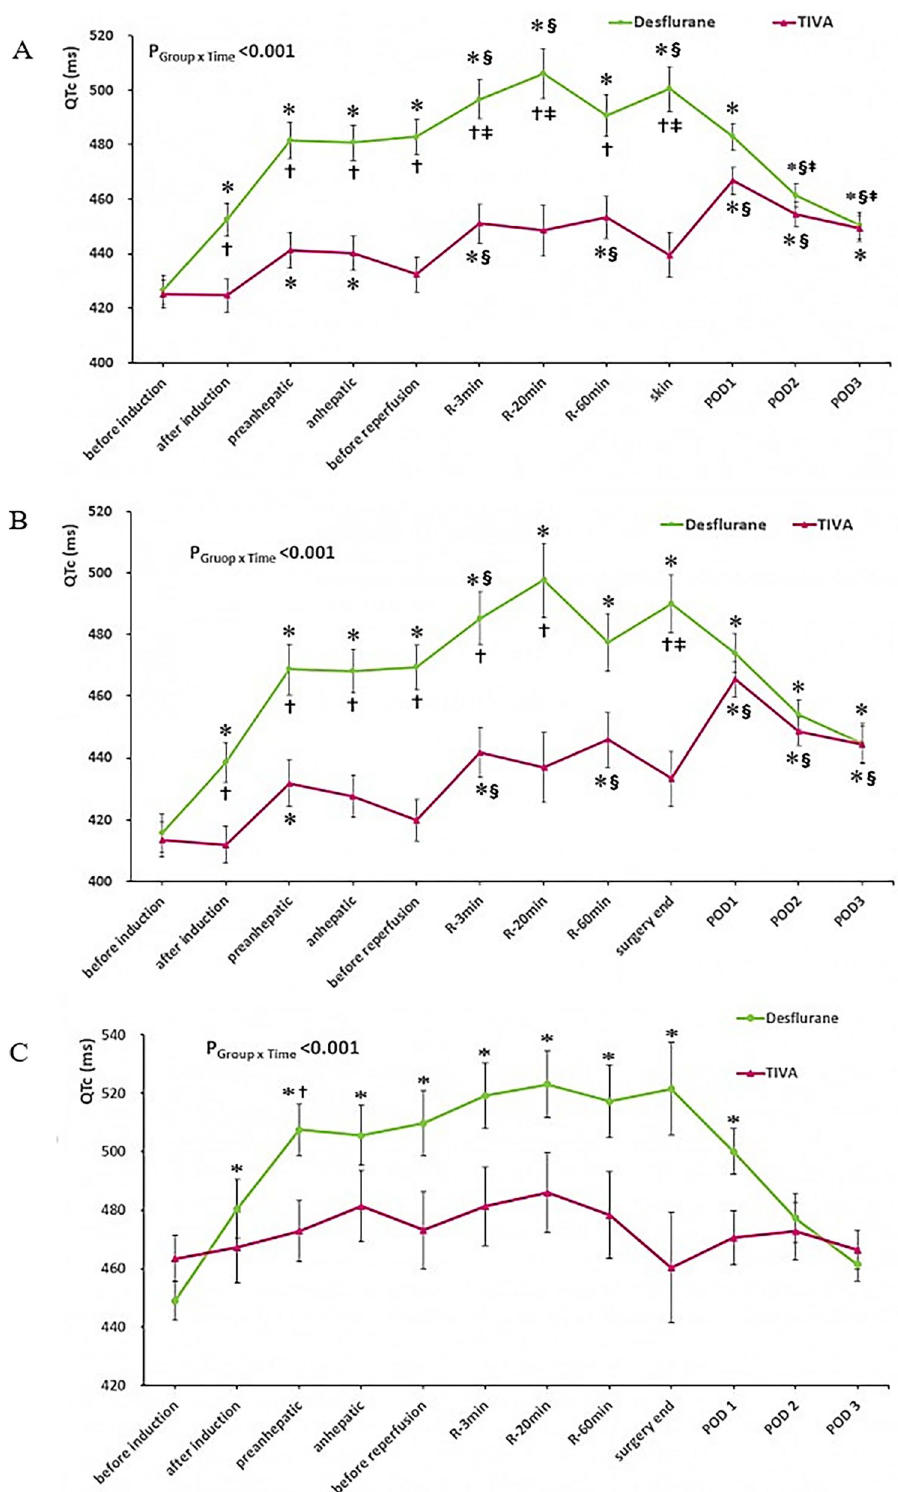
Figure 2. Intraoperative changes in heart rate corrected QT (QTc) intervals calculated by Bazett’s formula. Values are mean ± standard error. ( A ) QTc changes in all patients, ( B ) QTc changes in patients with normal preoperative QTc, ( C ) QTc changes in patients with preoperative QTc prolongation. *Bonferroni-corrected P values of < 0.05, compared with the value obtained before induction within the groups. §Bonferroni-corrected P values of < 0.05, compared with the value obtained before reperfusion within the groups. †Bonferroni-corrected P values of < 0.05, compared with the value obtained before induction between the groups. ‡Bonferroni- corrected P values of < 0.05 compared with the value of before reperfusion between the